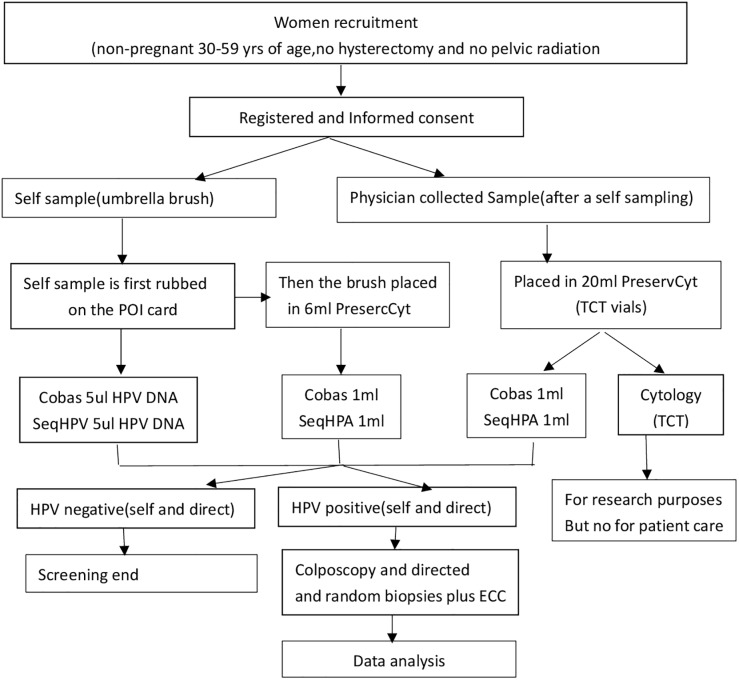
CHIMUST protocol.